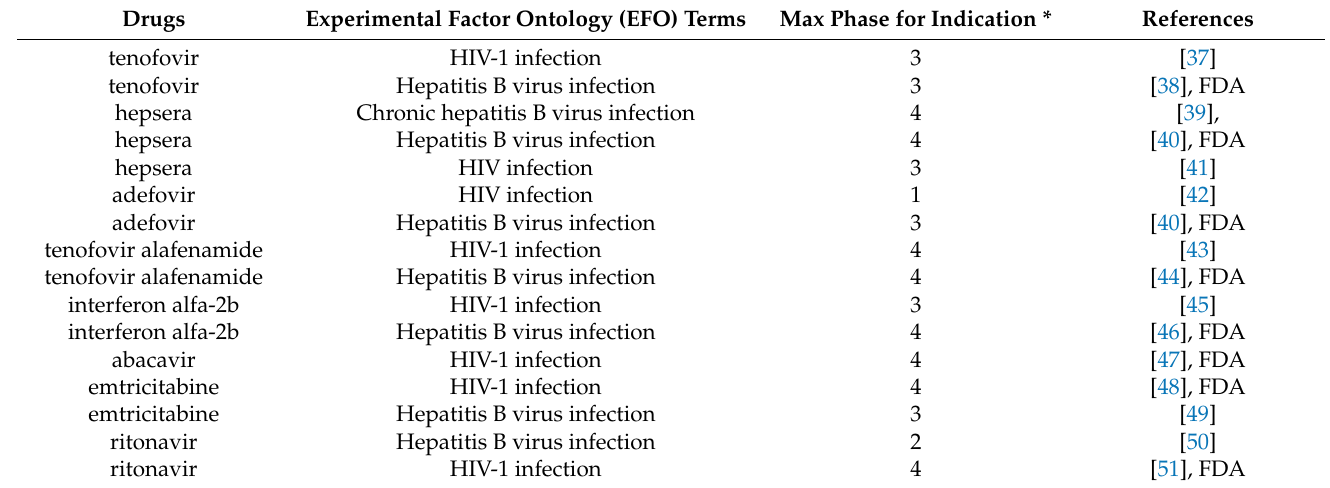
Table 2. Known experimental verification of approved HIV-1 and HBV